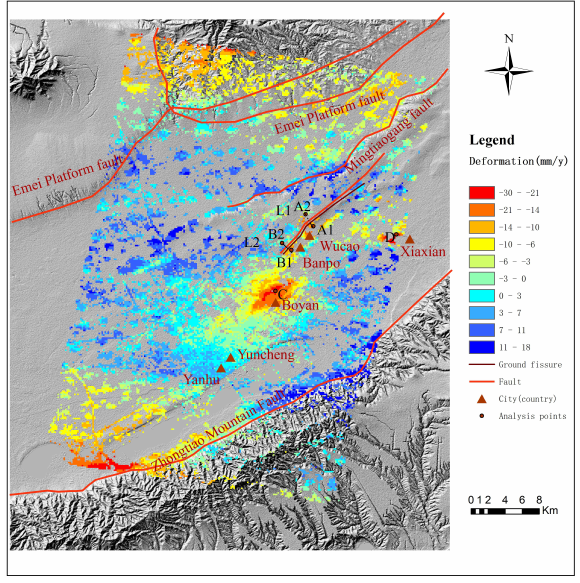
Figure 3. Deformation rate map